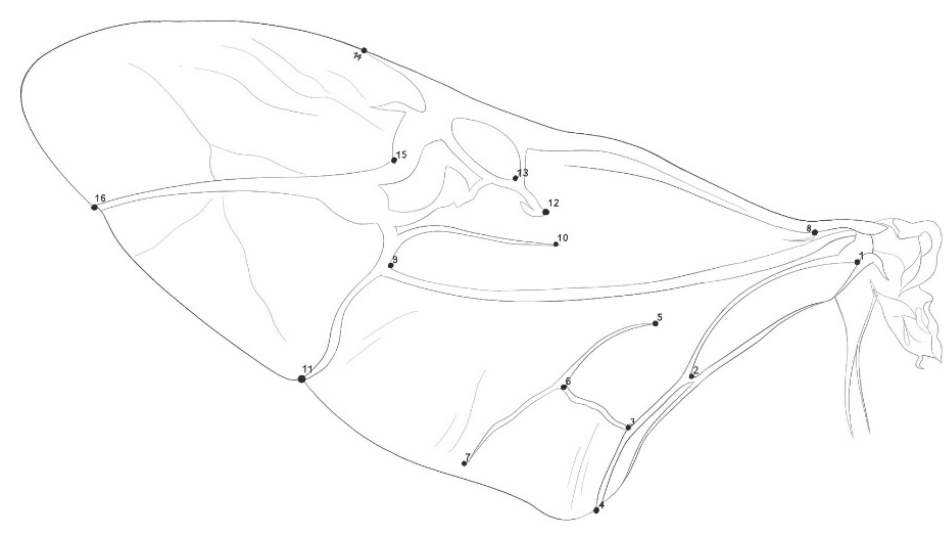
Figure 2. Colorado potato beetle hindwing schematic with sixteen type-one digitized landmarks.